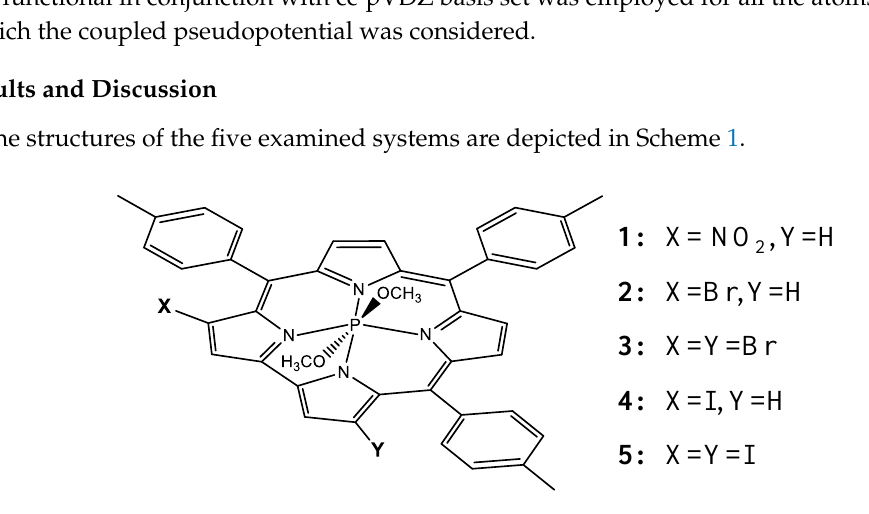
Table 1. B3LYP/6-31 + G * vertical excitation energies, ΔE (eV), λ (nm), oscillator strengths f and main transitions (H = HOMO, L = LUMO) for studied compounds, computed in dichloromethane. Experimental values are taken from [13].